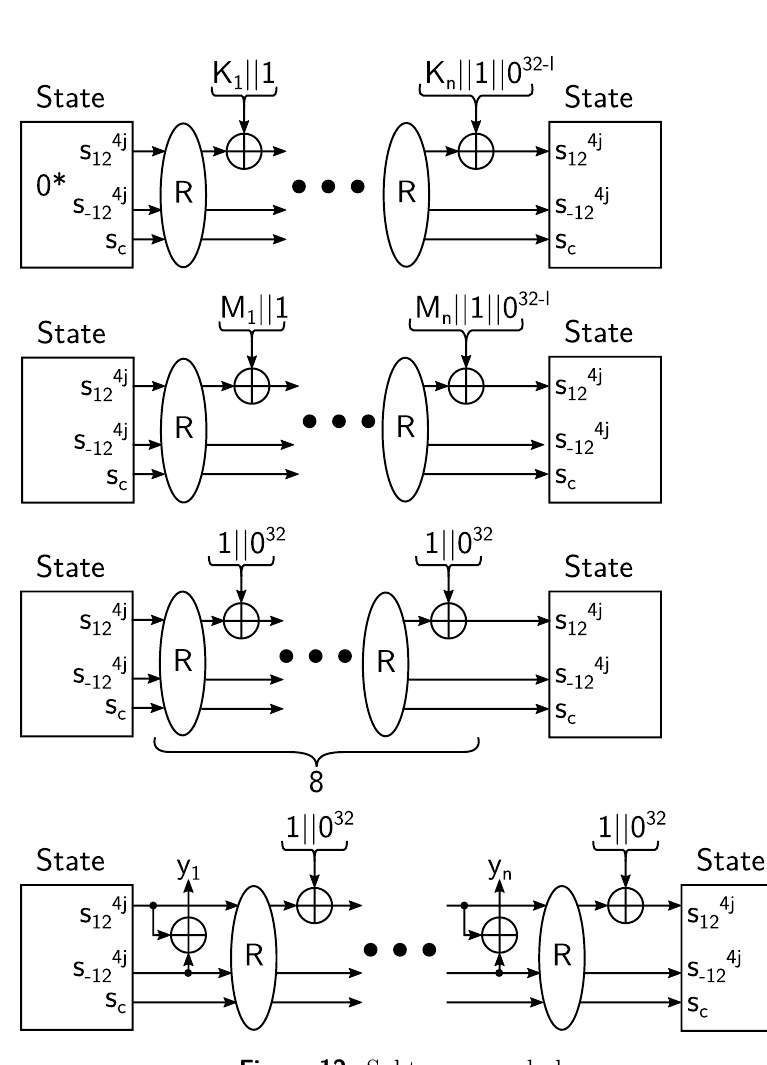
Figure 12: Subterranean